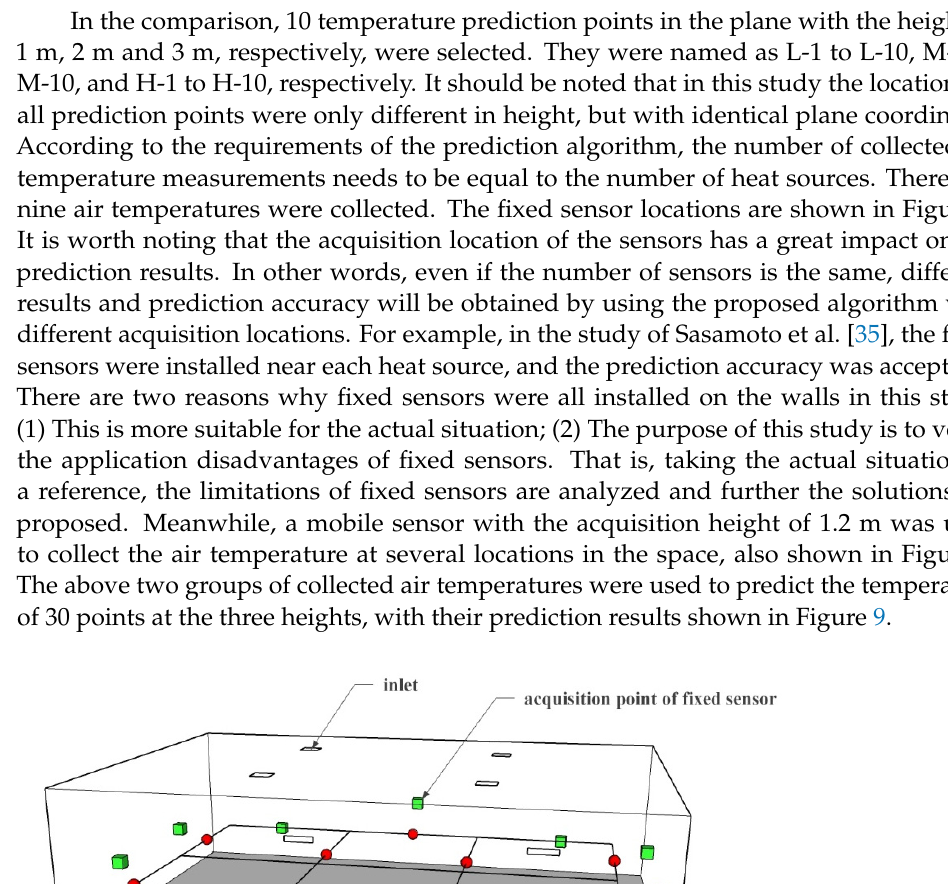
Table 2. Prediction of each point using fixed sensors and mobile